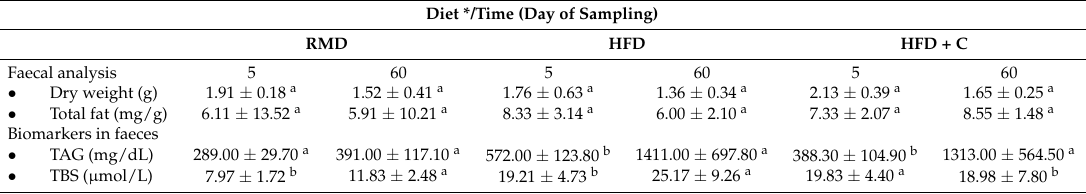
Table 3. Faecal analysis of the experimental groups (mean ± SD, n = 10).